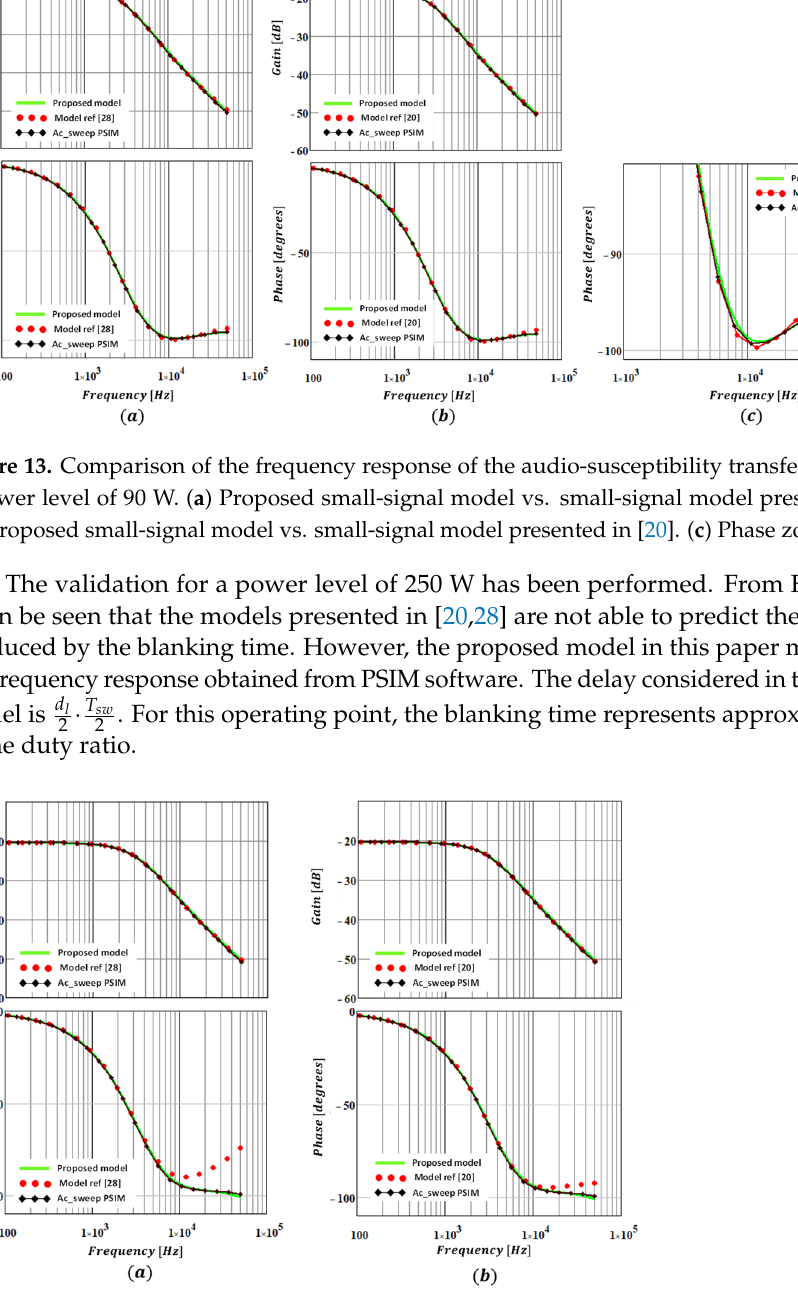
Figure 14. Comparison of the frequency response of the audio-susceptibility transfer function for a power level of 280 W. ( a ) Proposed small-signal model vs. small-signal model presented in [28]. ( b ) Proposed small-signal model vs. small-signal model presented in [20].